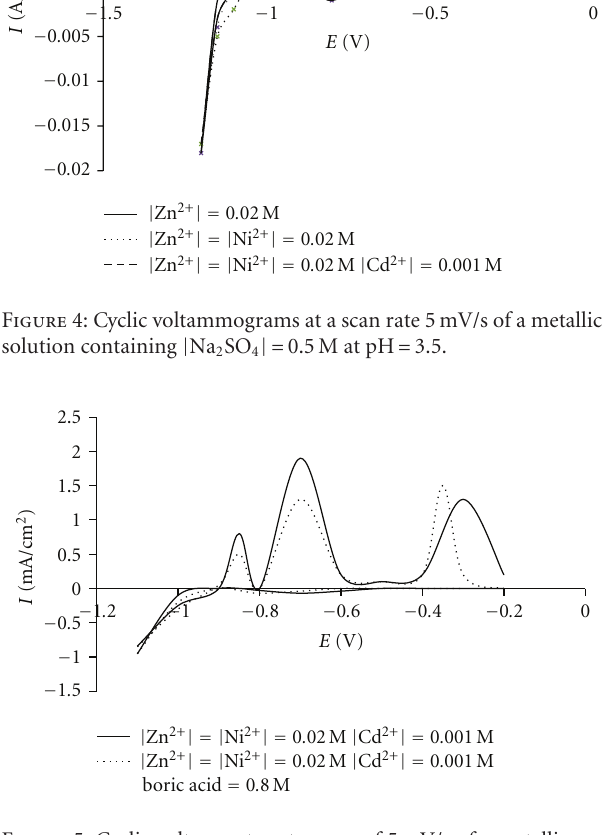
Figure 5: Cyclic voltammetry at a scan of 5mV/s of a metallic so- lution containing | Na 2 SO 4 | = 0.5M at pH =